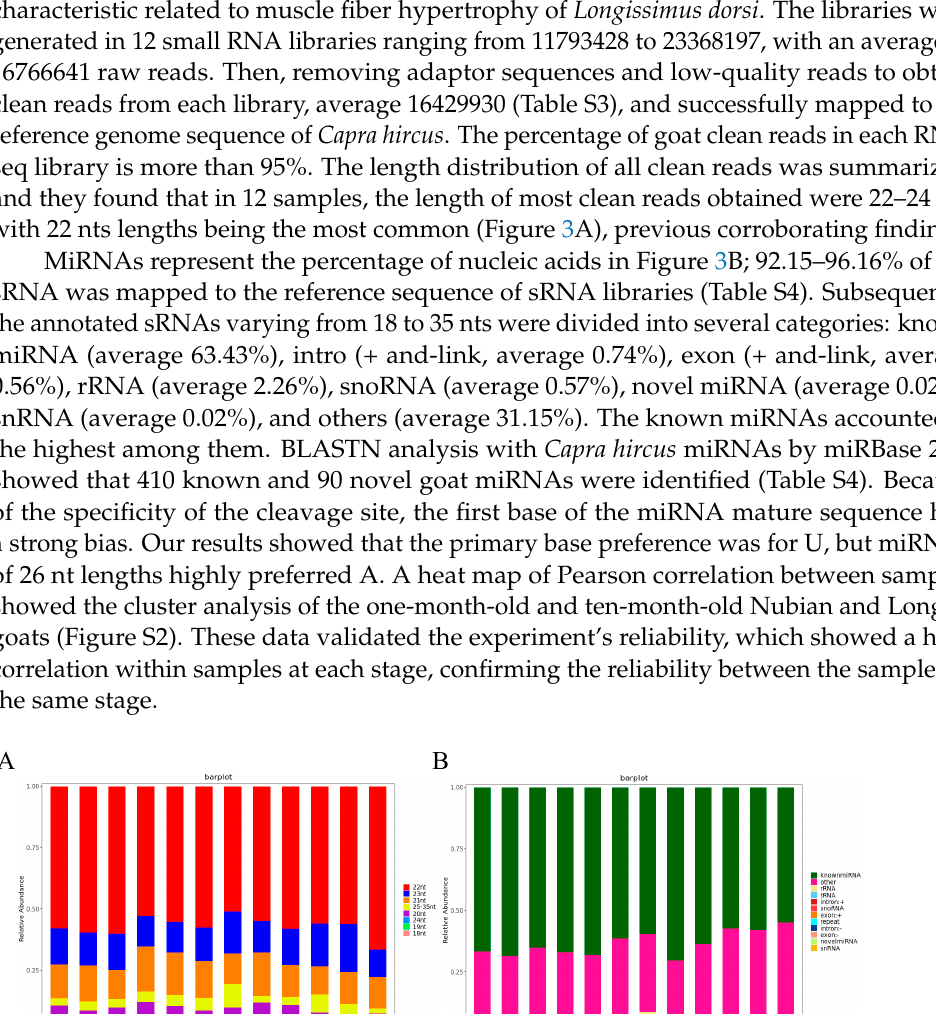
Figure 2. Differential expression analysis of mRNAs in longissimus dorsi between 1-month-old and 10-month-old Longlin goat. ( A ) Volcano plots of up-regulated and down-regulated DEGs of longissimus dorsi between 10-month-old and 1-month-old Longlin goat. The gray dots represent non-significantly DEGs, the 327 red dots represent significantly differentially up-regulated mRNAs, and the 419 blue dots represent significantly differentially down-regulated mRNAs. ( B ) GO analysis of DEGs of longissimus dorsi between 10-month-old and 1-month-old Longlin goat. Light green represents terms of up-regulated gene; Light red represents terms of down-regulated gene. ( C ) KEGG analysis of DEGs of longissimus dorsi between 10-month-old and 1-month-old Longlin goat. Light green represents terms of up-regulated genes; Light red represents terms of down-regulated genes. ( D ) RT-qPCR of DEGs compared with RNA-seq. Results of RT-qPCR analysis (Parallel analysis with RNA-seq results) of DEGs fold-change in longissimus dorsi between 10-month-old and 1-month-old Longlin goat. The relative expression of each mRNA was calculated using the 2 −ΔΔ ct method. The data are presented as mean ± SEM from three independent experiments.